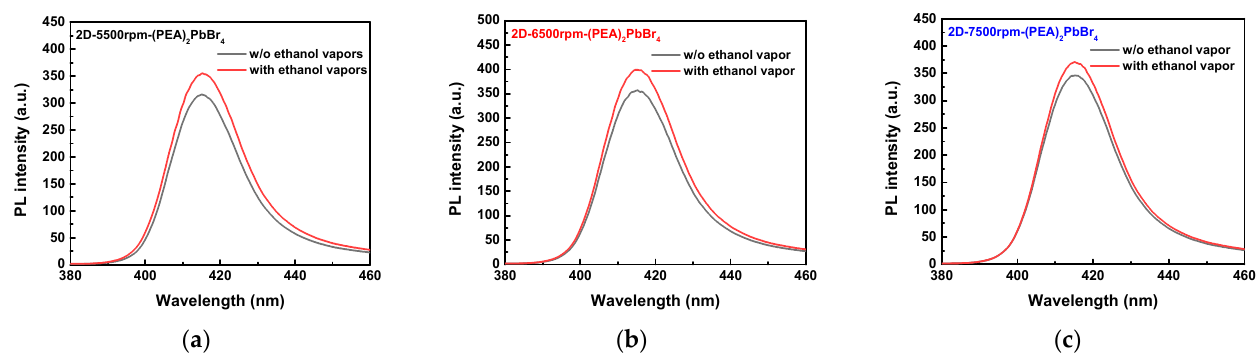
intensities slightly increased. However, as the 2D-(PEA) 2 PbBr 4 film thickness changed, the PL intensities varied. The PL intensity of the 2D-(PEA) 2 PbBr 4 film formed at 6500 rpm was the highest. Thus, the corresponding crystal structure was denser and more uniform, which was consistent with the I–V measurements . Figure 8. X-ray diffraction (XRD) patterns of 2D-(PEA) 2 PbBr 4 films formed with different spin speeds.